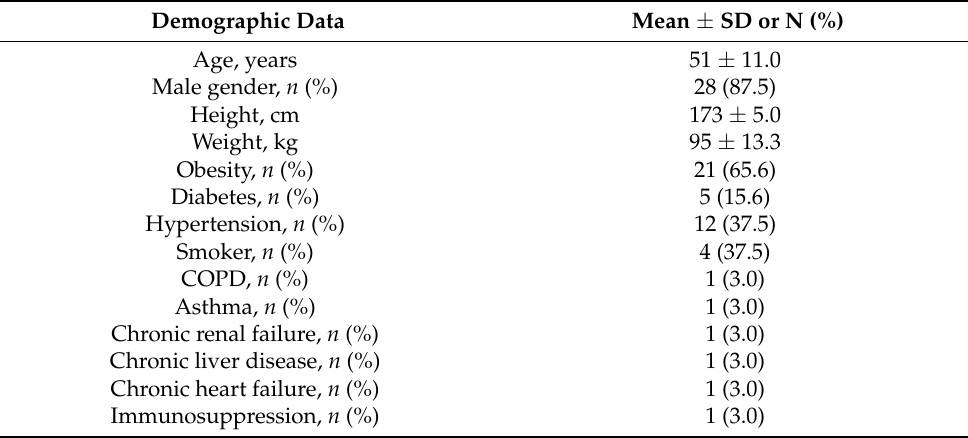
Table 1. Baseline characteristics and demographic features. Dichotomous variables are reported as count and percentage; continuous variables are expressed as mean ± standard deviation. (COPD: chronic obstructive pulmonary disease; RPM: round per minute; FiO 2 : inspiratory oxygen fraction; MV: mechanical ventilation; SD: standard